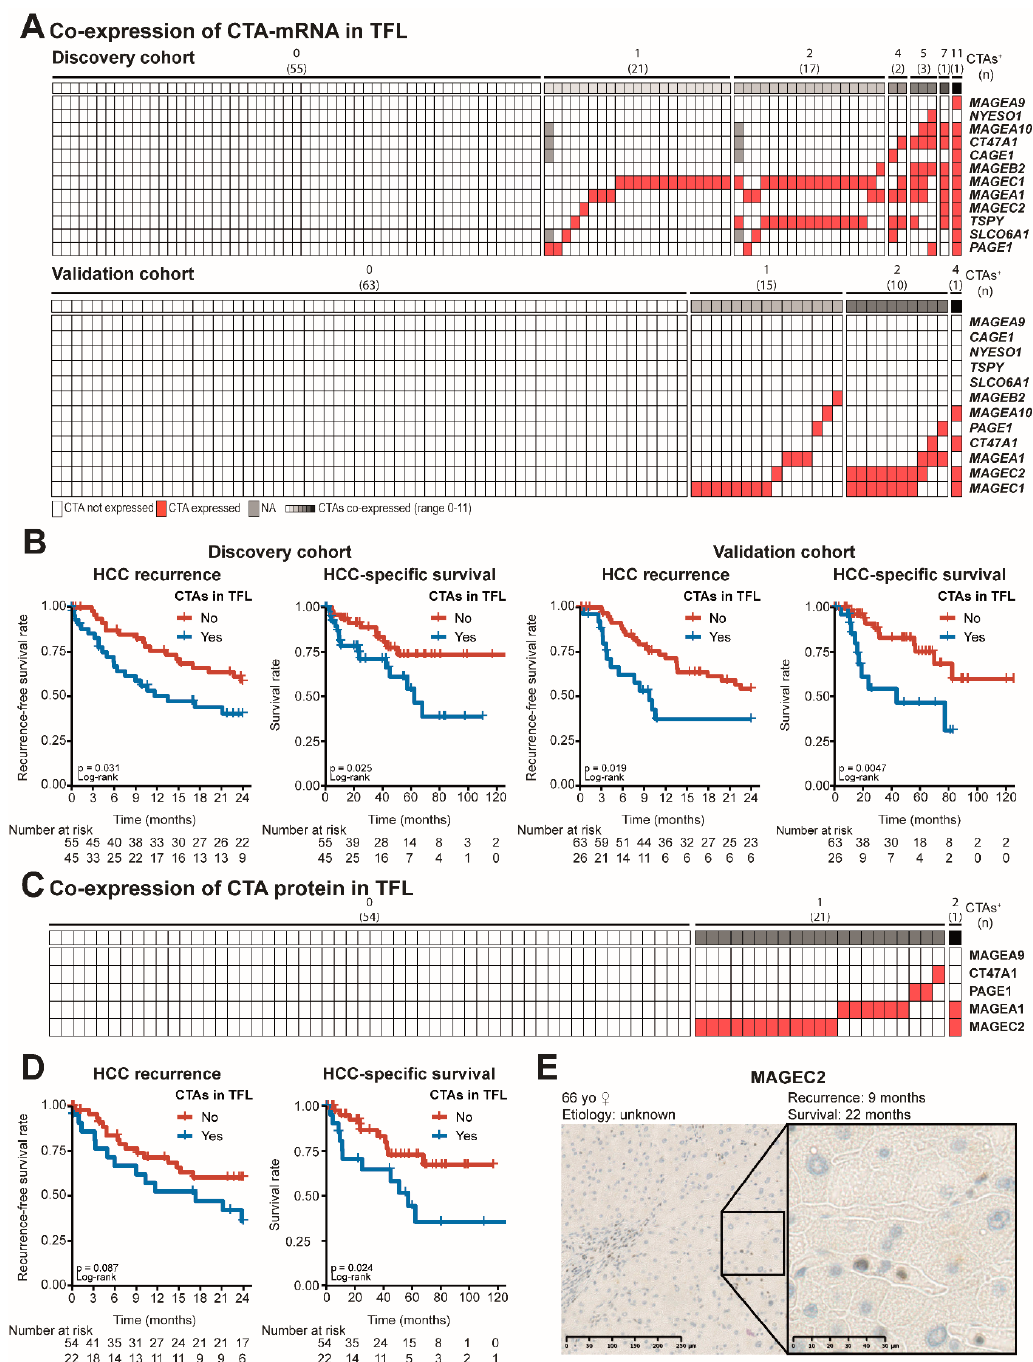
Figure 4. Both mRNA and protein expression of CTAs in TFL are associated with HCC recurrence and HCC-specific survival. ( A ) Heatmap indicating co-expression of CTA mRNA in tumor-free liver tissue in the discovery and validation cohort. ( B ) Early HCC recurrence and HCC-specific survival in HCC patients by CTA mRNA expression in TFL in the discovery and validation cohort. Plus-signs indicate censored data. Cox–Mantel log-rank test. ( C ) Heatmap indicating co-expression of CTA protein in tumor-free liver tissue. ( D ) Early HCC recurrence and HCC-specific survival in HCC patients by CTA protein expression in TFL. Plus-signs indicate censored data. Cox–Mantel log-rank test. ( E ) Representative example of IHC staining of MAGEC2 protein expression in TFL and accompanying patient data. TMA slides were scanned by a Nanozoomer (Hamamatsu), and analyzed by NDP.view2 software